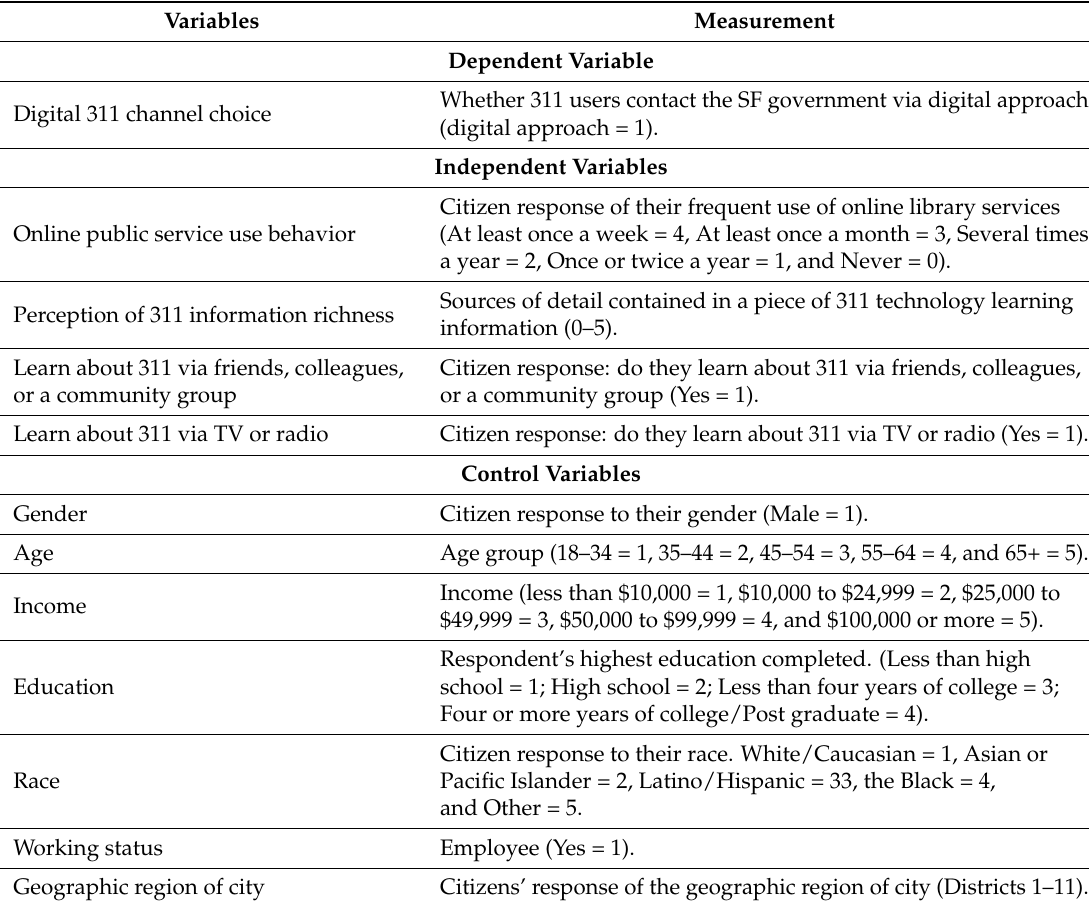
Table 1. Summary of indicator